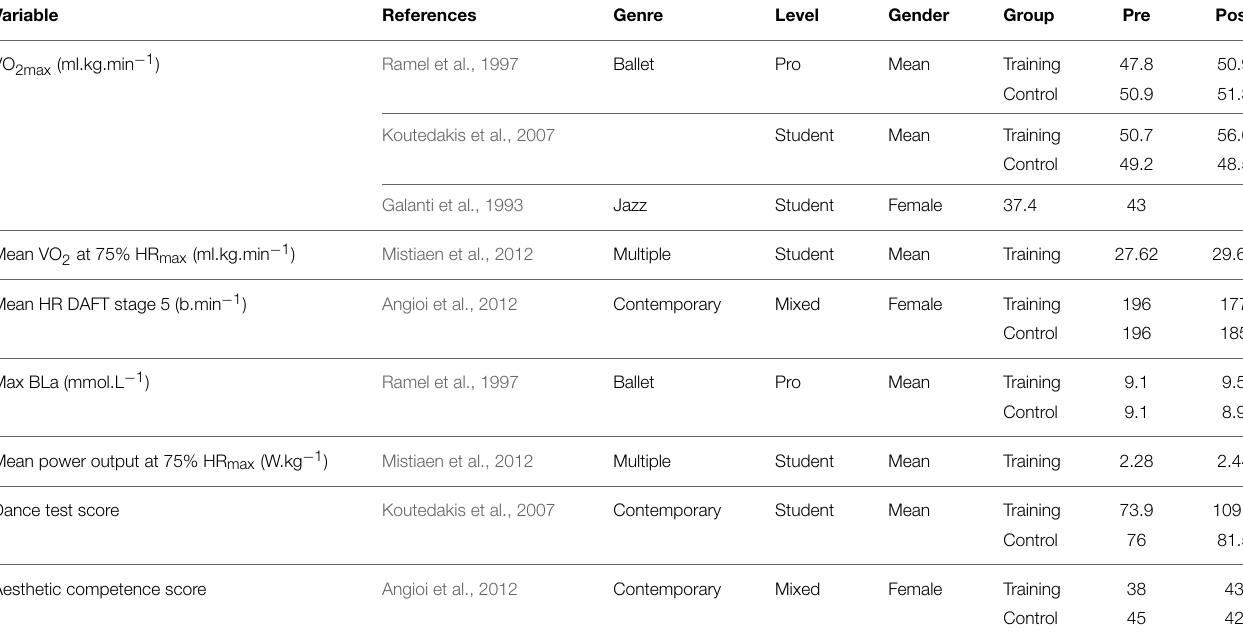
TABLE 6 | Mean data of studies examining measures of cardiorespiratory fitness pre- and post- implementation of a training intervention.